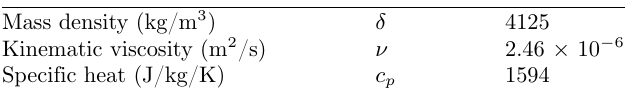
Table 2. LiF-ThF 4 fuel salt reference thermo-physical